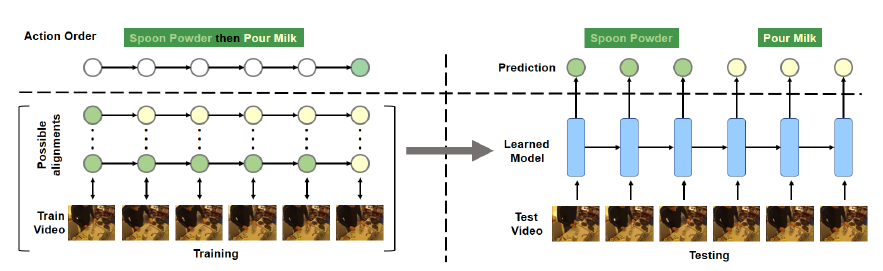
Figure 1. The training/testing settings in the problem of action labeling through temporal alignment learning. ( Left ) During training, only the order of the occurring actions is given, the model is learned by maximizing the probability of all possible frame-to-label alignments. ( Right ) During testing, no annotation is given, as the learned model already encodes the temporal structure of data, it predicts the actions frame by frame without any further